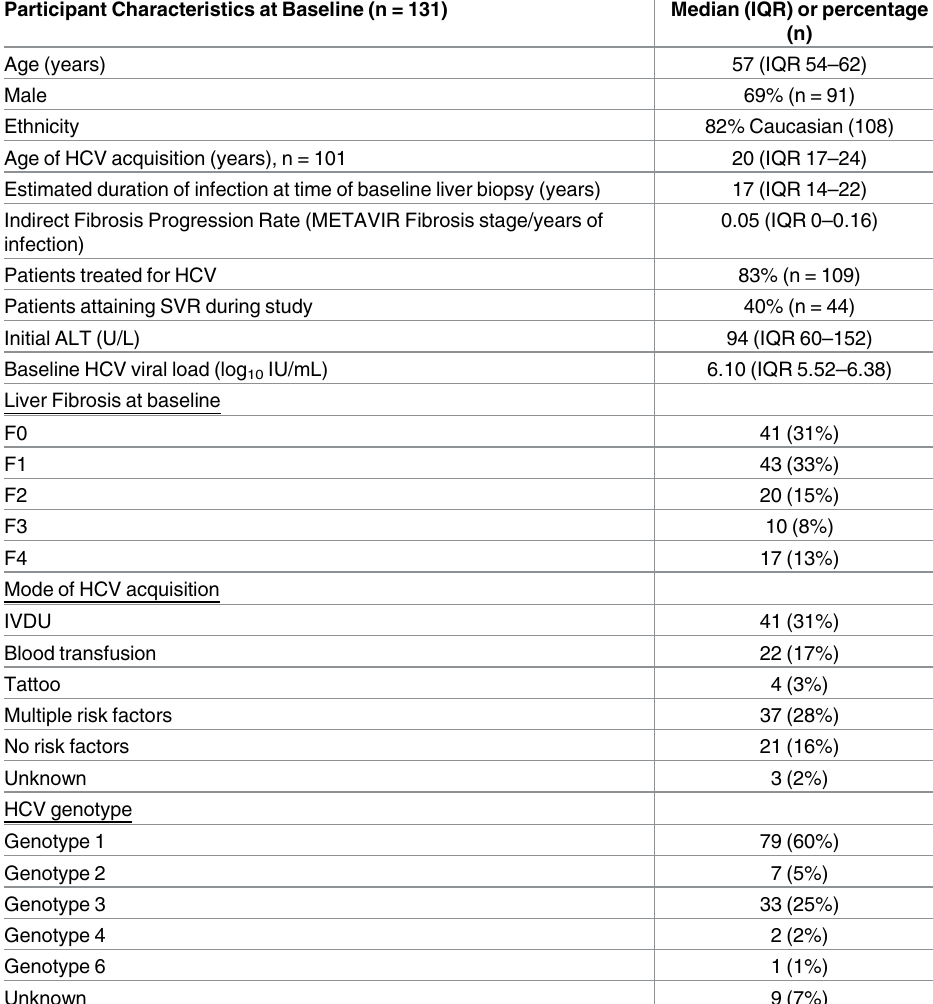
Table 1. Participant characteristics at